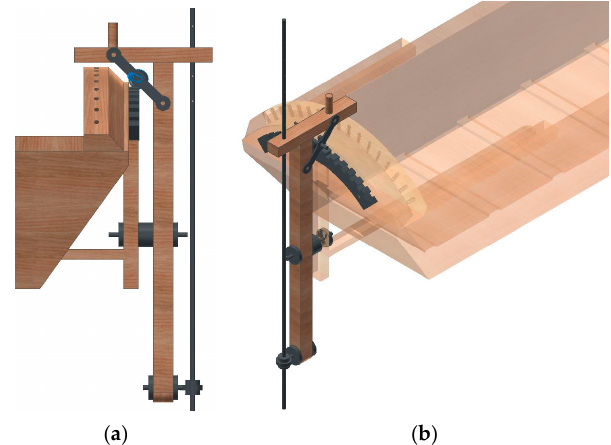
Figure 7 . Detail of the vertical pivoting axle. ( a ) Lateral view; ( b ) axonometric view.